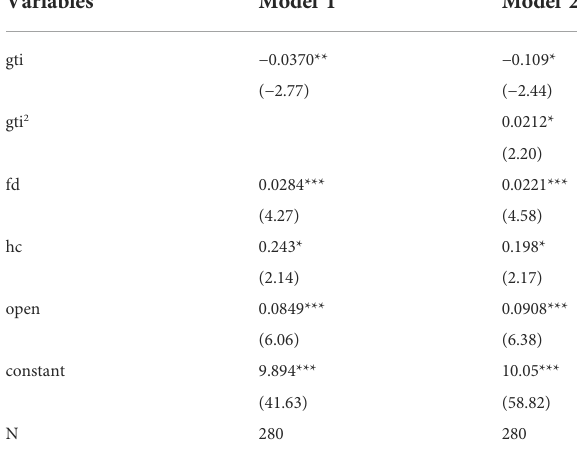
TABLE 5 Regression results of basic